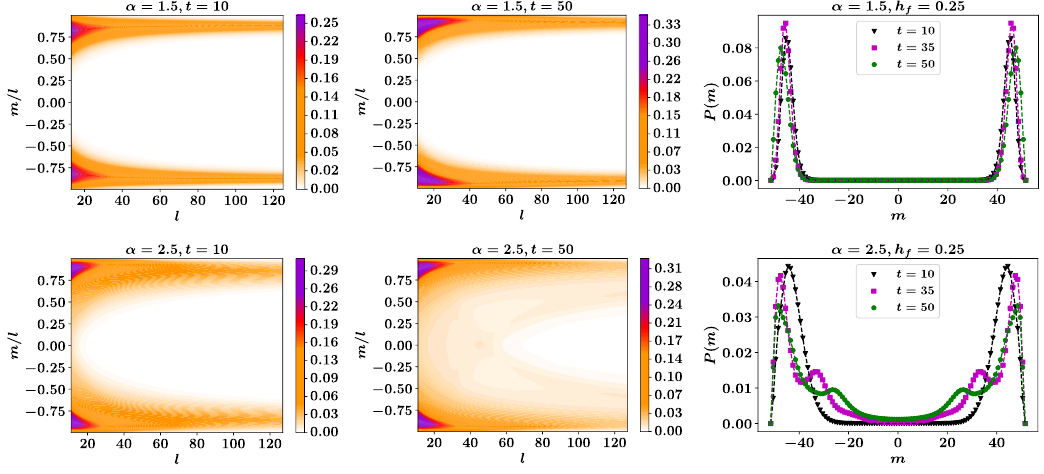
= 0.25 (in first and f